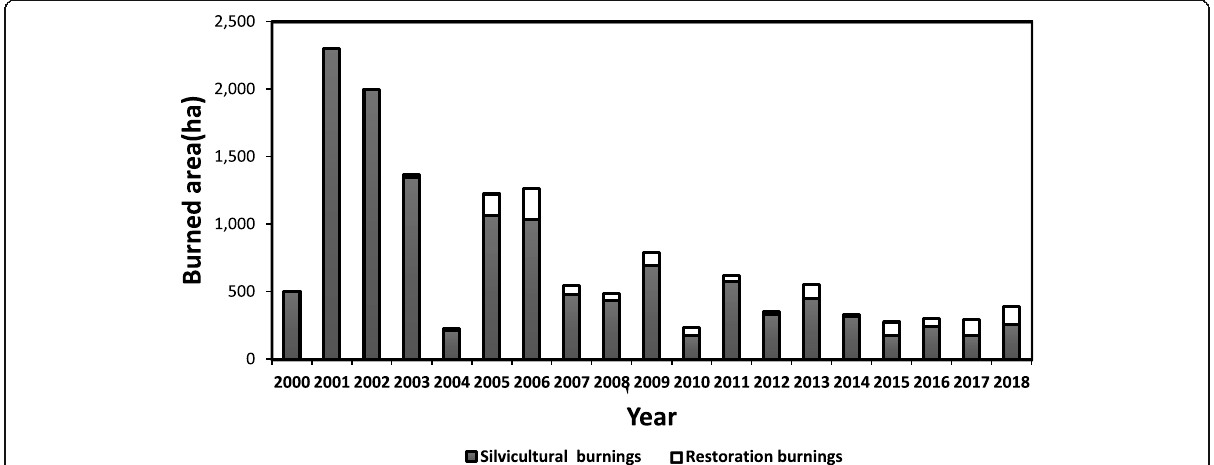
Fig. 5 Annual areas (hectares) of prescribed burnings (silvicultural and restoration burnings presented separately) in Finland 2000 – 2018 (sources: silvicultural burnings: Finnish Forest Statistics 2019; restoration burnings: Rauli Perkiö, Metsähallitus Parks & Wildlife Finland, pers.